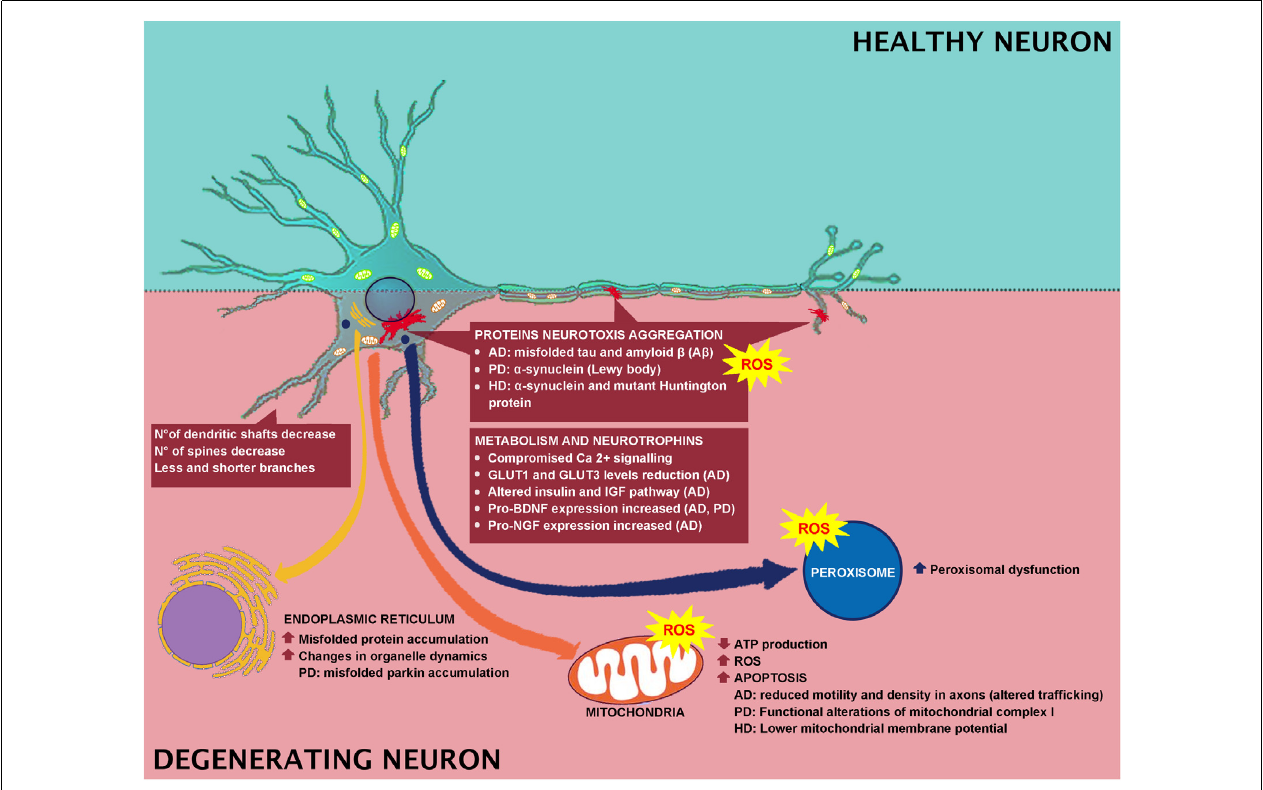
FIGURE 2 | Effect of degeneration in neuronal cell and involved mechanisms.